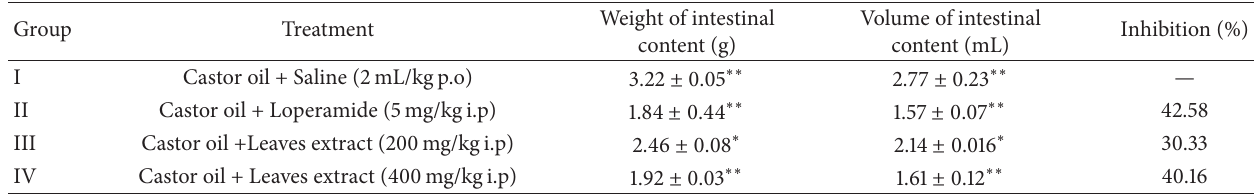
Table 2: Effect of MEMA leaves on castor oil induced enterpooling in